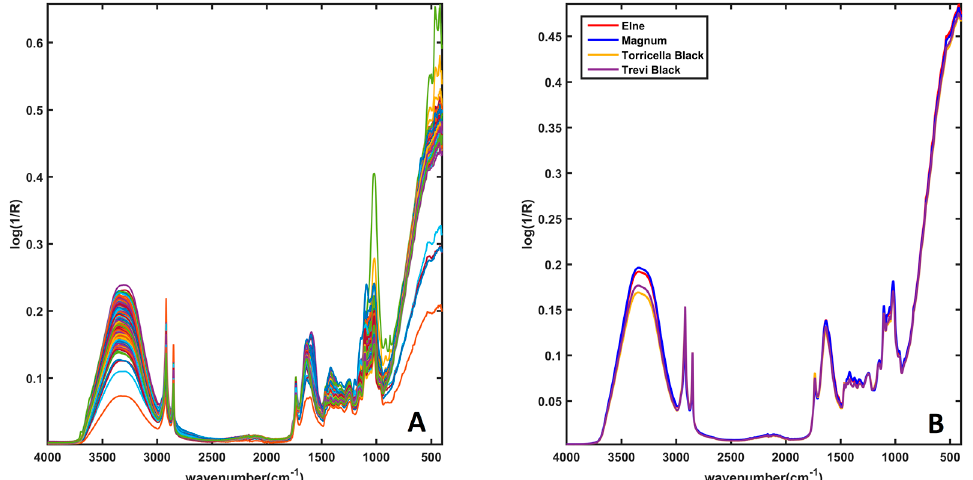
Figure 1. FT-IR spectra. Plot ( A ): spectra of all the analyzed samples. Plot ( B ): mean spectra of samples belonging to the four classes. Legend: Elne — red line; Magnum — blue line; Torricella — yellow line; Trevi — purple line.